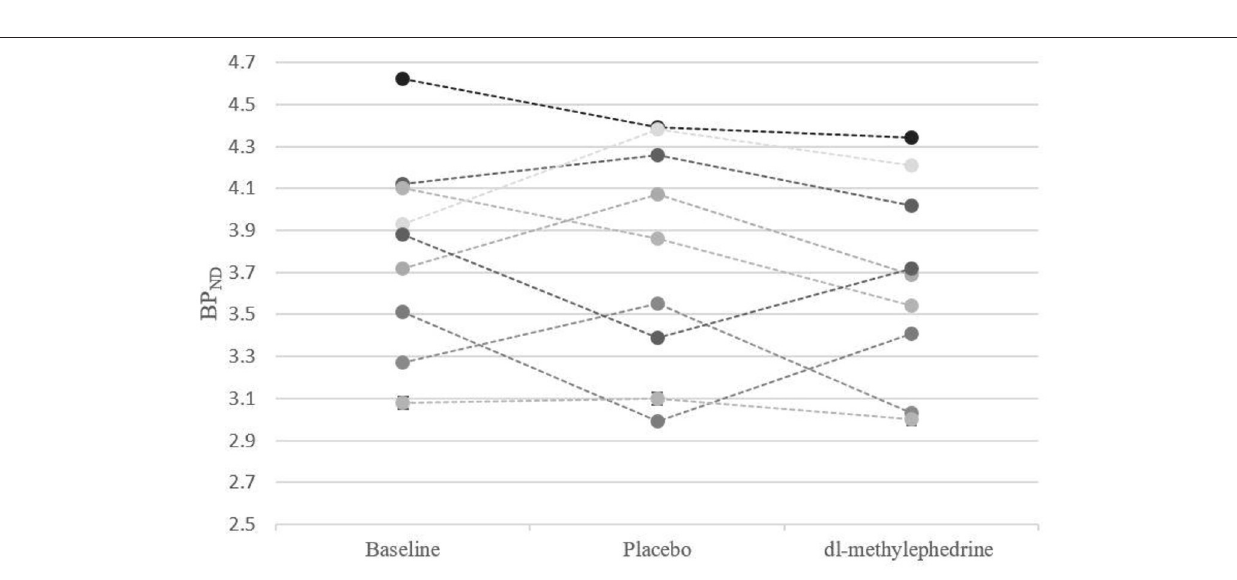
FIGURE 3 | BP ND in putamen for each subject at baseline, placebo, and 60mg of